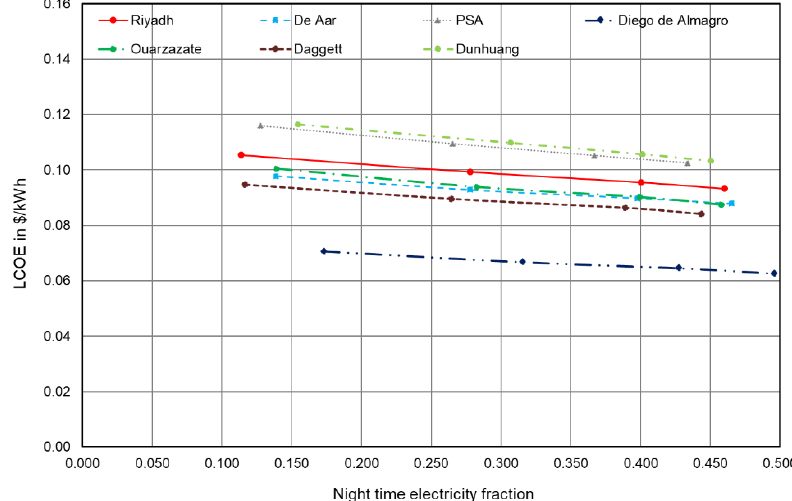
Figure 5. Comparison of locations: standalone tower.